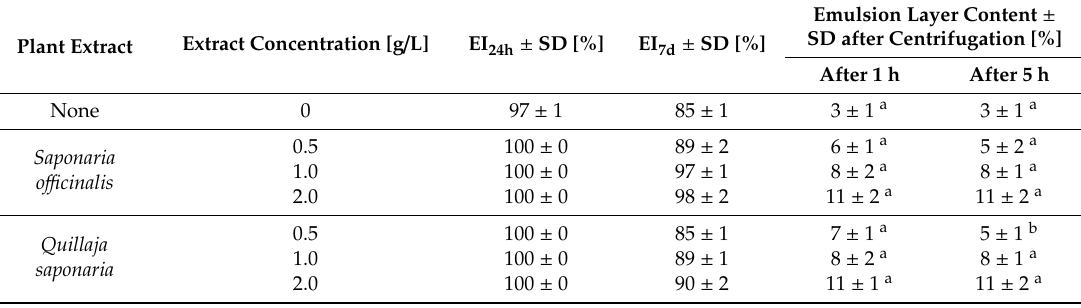
Table 2. Emulsification index after 24 h (EI 24h ) and 7 days (EI 7d ) of emulsion storage and emulsion content after sedimentation test with centrifuging at 2500 × g